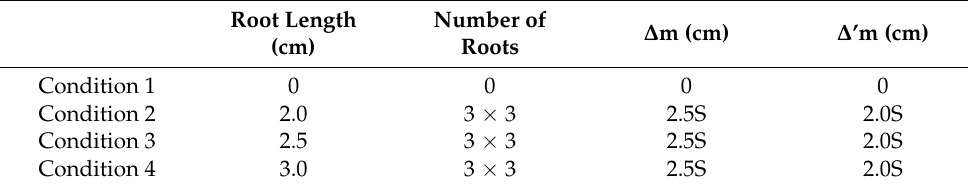
Figure 5. Schematic diagram of the physical model experiment system. Table 2. Testing scheme.